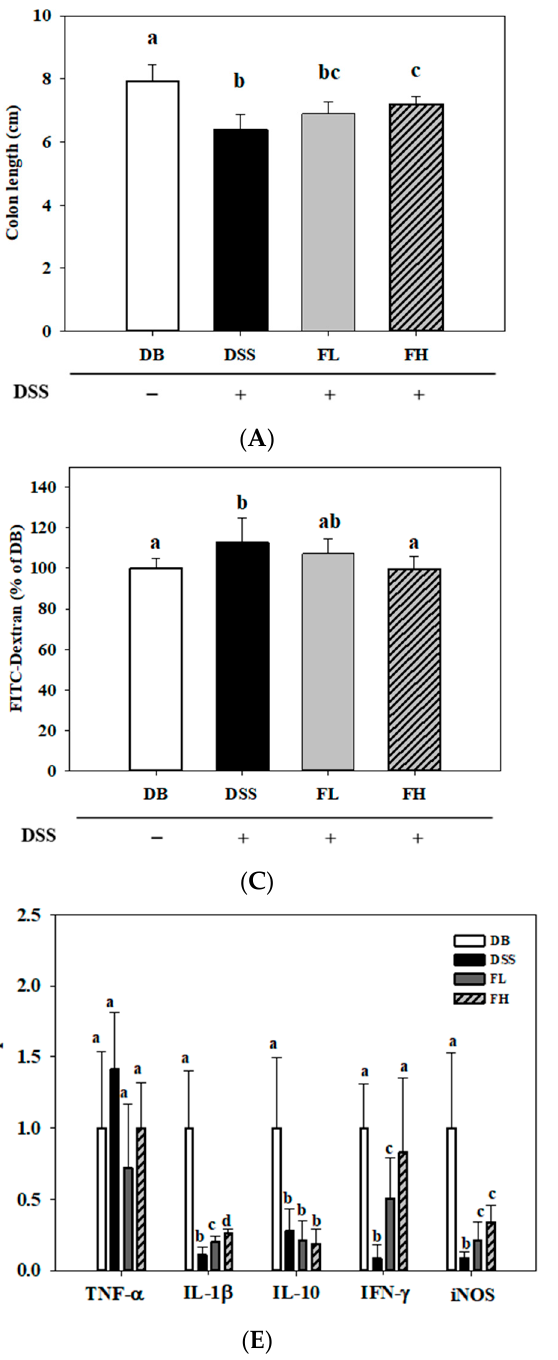
Figure 3. Effects of FMRP on the colon length ( A ), disease activity index (DAI) ( B ), intestinal permeability ( C ), myeloperoxidase (MPO) ( D ), mRNA expression of inflammatory factors ( E ), and epithelial junction markers ( F ) in the colon tissue. DSS +/- indicates whether 2% DSS is treated or not. Different letters (a–c) denote a significant difference at p < 0.05 calculated using one-way ANOVA with Tukey’s multiple comparison test. Data are expressed as means ± SD. Six mice were included per group.